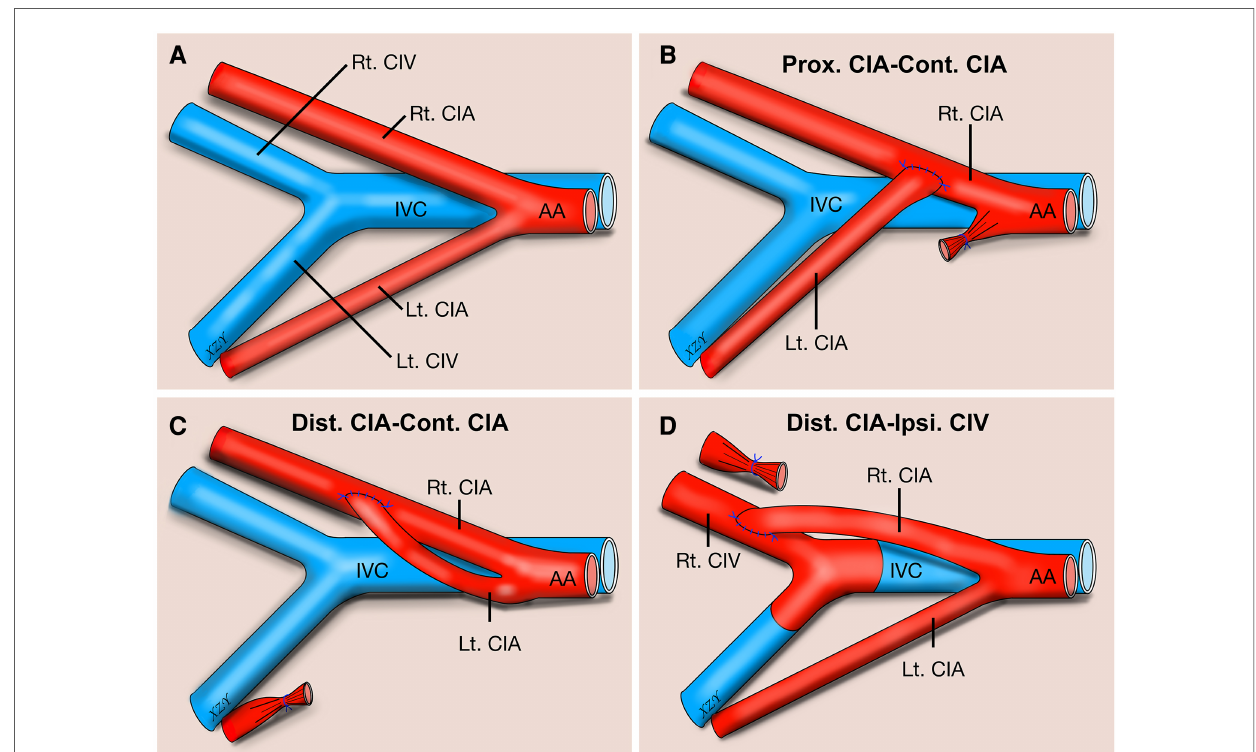
FIGURE 1 Schematic illustration about three types of end-to-side microvascular anastomosis training model using rat common iliac artery. Anatomy schematic illustration of the rat CIA regarding three types of end-to-side microvascular anastomosis training model using rat CIA ( A ). Prox. CIA to contralateral CIA end-to-side anastomosis ( B ). Distal CIA to contralateral CIA end-to-side anastomosis ( C ). Distal CIA to ipsilateral CIV end-to-side anastomosis ( D ). AA, abdominal aorta; CIA, common iliac artery; CIV, common iliac vein; Cont., contralateral; Dist., distal; Ipsi., Ipsilateral; IVC, inferior vena cava; Lt., left; Prox., proximal; Rt.,